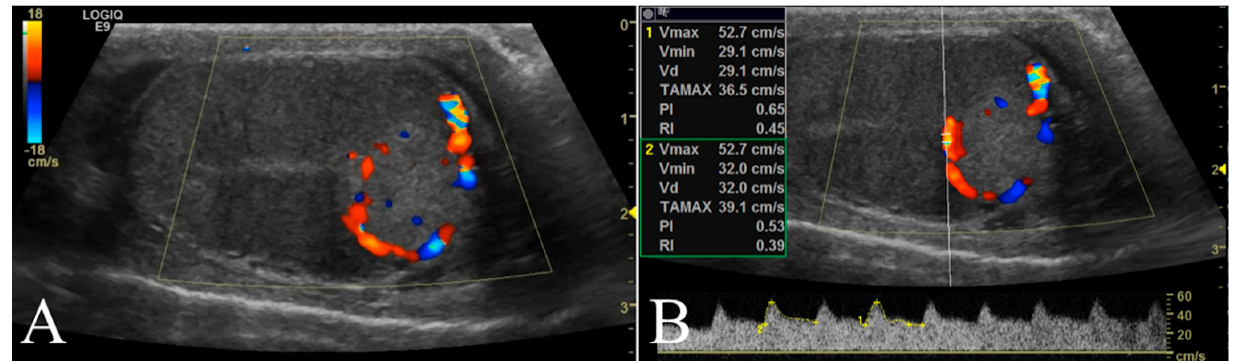
Figure 2. Representative Doppler characterization of a nodular lesion (leydigoma) found in the left testicle of a 11 year old Italian Mastiff. In particular, picture 2 ( A ), recorded by color Doppler, allowed the visualization of blood flow distributed peripherally to the lesion, while picture 2 ( B ) showed the same blood flow sampled by pulsed wave mode for quantitative analysis.